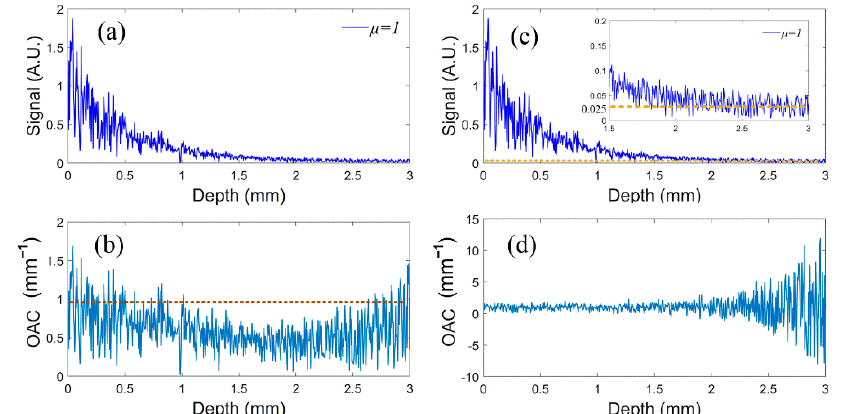
Figure 2. ( a ) Simulated signal that contains multiplicative noise (Gaussian distribution with zero mean and a variance of [ C × y ] 2 , C = 0.447) and additive noise (Gaussian distribution with a mean of 0.025 and a variance of 1). ( b ) The corresponding OAC obtained by using Equation (2), the yellow dotted line is the OAC of the ideal OCT signal; the OAC of noisy OCT signals is seriously underestimated. ( c ) The mean of noise floor b (the yellow dotted line) is subtracted from the simulated signal. ( d ) The corresponding OAC of ( c ), the fluctuations range in the OAC increases rapidly with the depth.